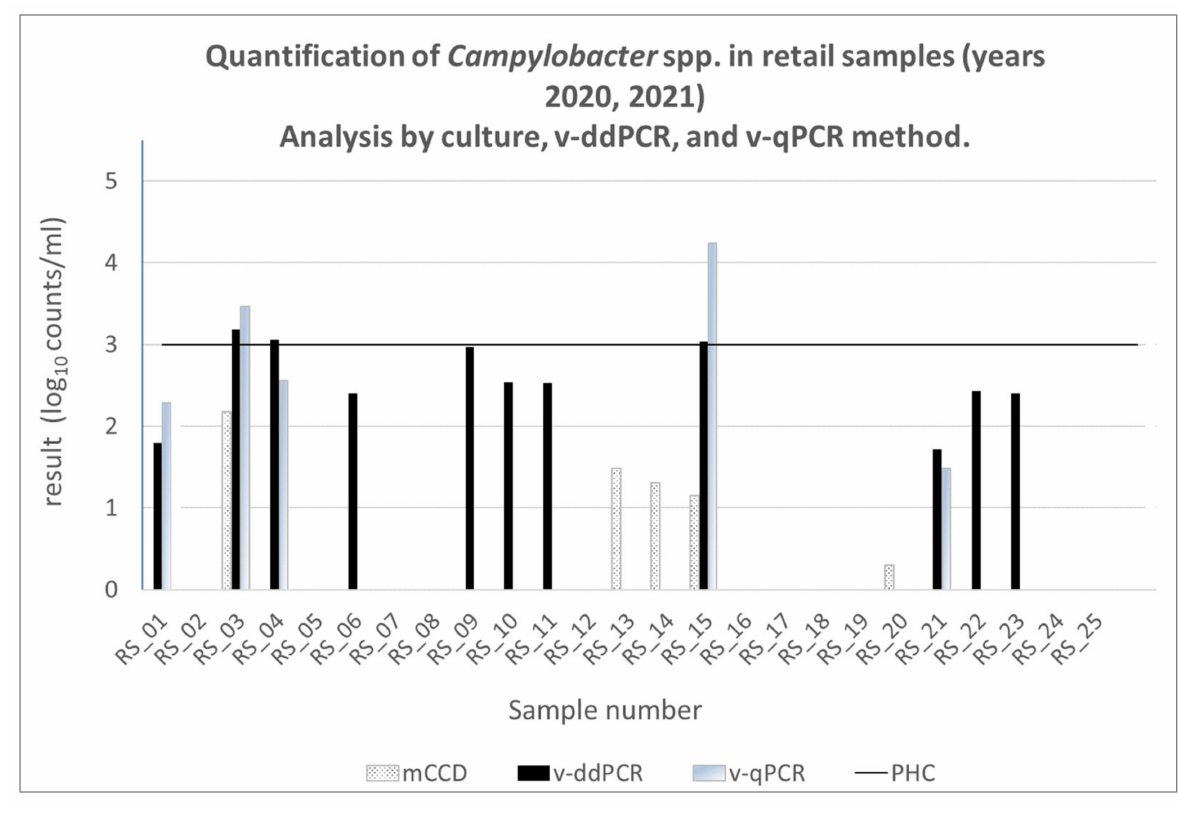
Figure 6. Analysis of different raw chicken (RS) meat samples from retail supermarket on culture, v-ddPCR and v-qPCR method. The Process Hygiene Criterion (PHC: log 10 3.0) is marked with a black